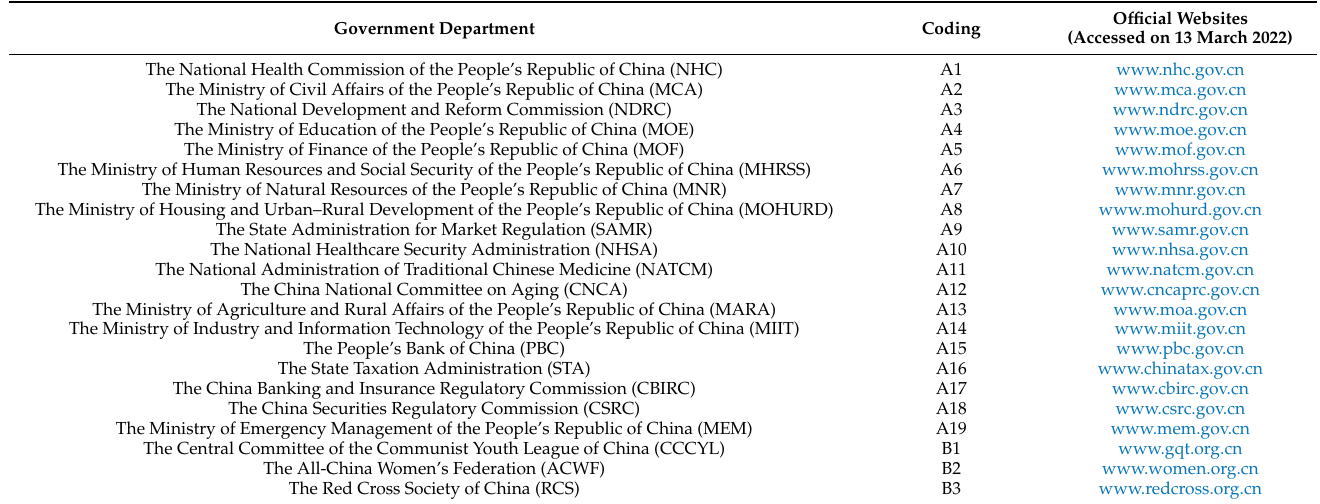
Table 1. The characteristics of the target government departments and public